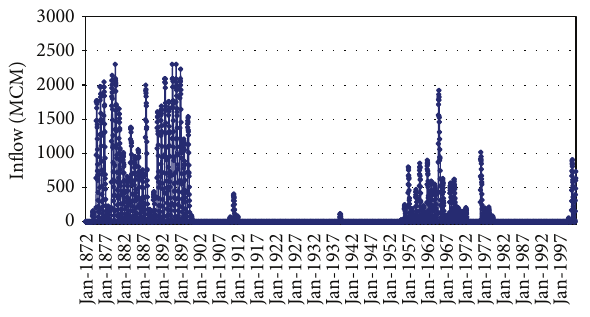
Figure 9: Realistic inflow time